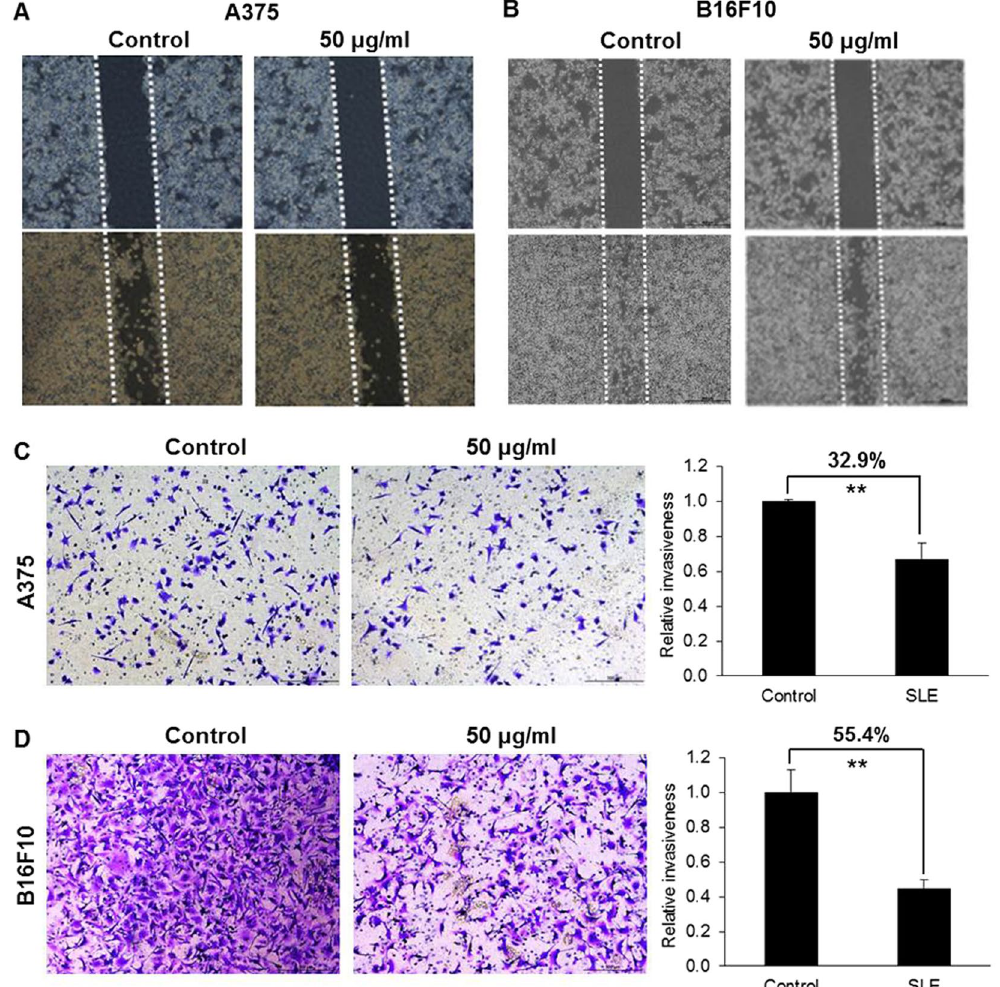
Figure 4. Inhibitory effects of SLE on melanoma cell migration and invasion. Representative photographs of A375 ( A ) and B16F10 ( B ) cell migration after SLE (50 μ g/mL) treatment. Cells seeded in 6-well plates were grown to 80–90% confluence. A single scratch was made in the cell monolayer, and followed by vehicle control or SLE treatment for 24 h. Pictures were taken at 0 and 24 h after treatment. Effects of SLE on A375 ( C ) and B16F10 ( D ) cell invasion were examined using the matrigel invasion assay. Representative photographs of invaded cells (left) and quantification of invasiveness (right) were shown. Cells (1.5 × 10 5 ) in DMEM-0.1% BSA with SLE (50 μ g/mL) or vehicle control were allowed to pass through matrigel coated membrane for 24 h. Cells on the lower surface of the membrane were considered as invaded cells. Number of invading cells was determined as the average cell number in 5 random microscope areas for each condition for each separate replicate experiment. Data were shown as mean ± SD from three independent experiments, ** P <